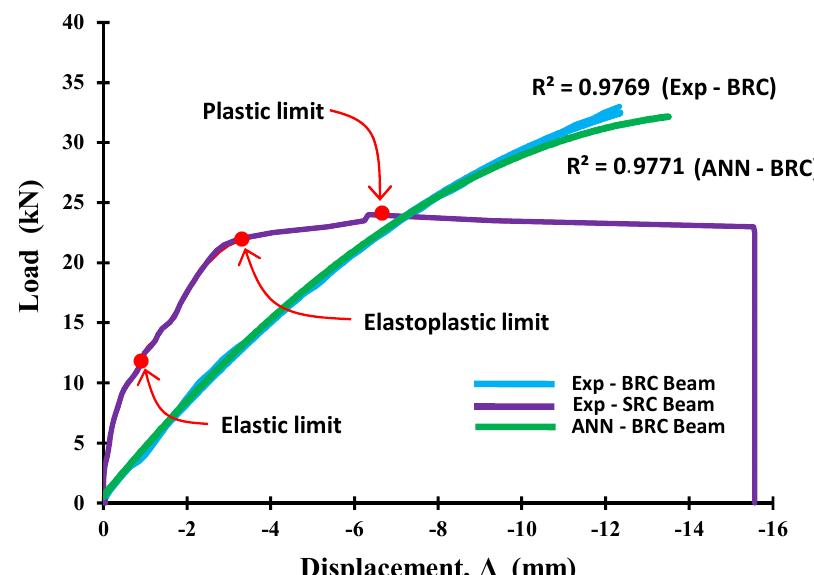
Figure 19. The combined of the load vs. displacement relationship of BRC beam of the experimental results and ANN analysis.